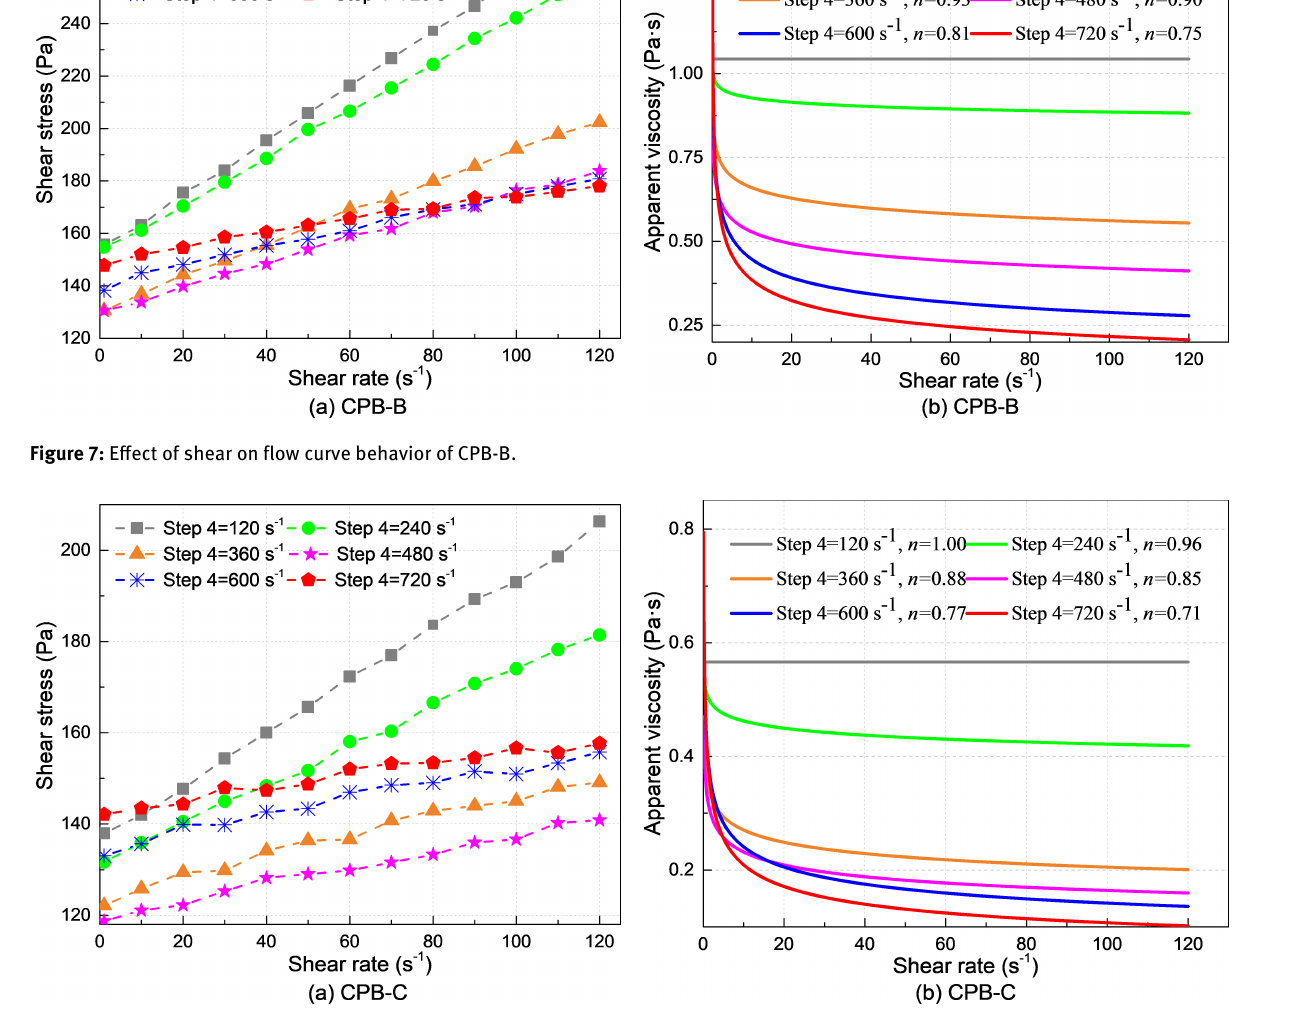
fill with increasing cement content and containing super-